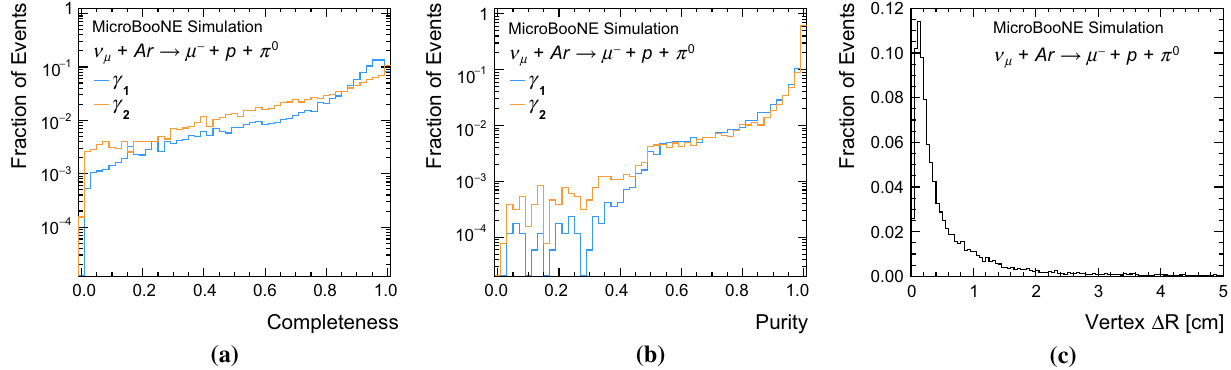
Fig. 19 Completeness ( a ) and purity ( b ) of the reconstructed particles with the strongest matches to the target photons ( γ 1 is the photon with the largest number of true hits, γ 2 has fewer true hits) in simulated